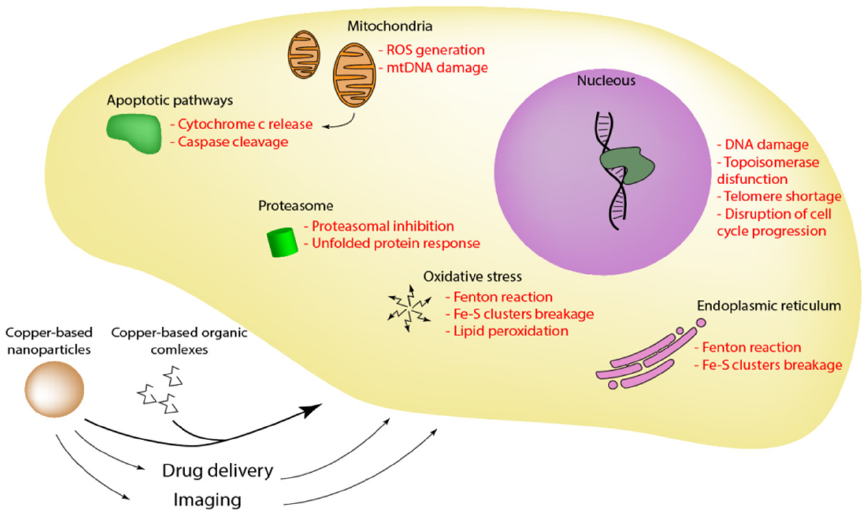
Figure 2. The main effect of copper nanoformulations on cell metabolism. The major impact of copper on cell metabolism is a result of ROS generation and DNA damage. Proteasome, endoplasmic reticulum, and mitochondria also suffer from copper excess.